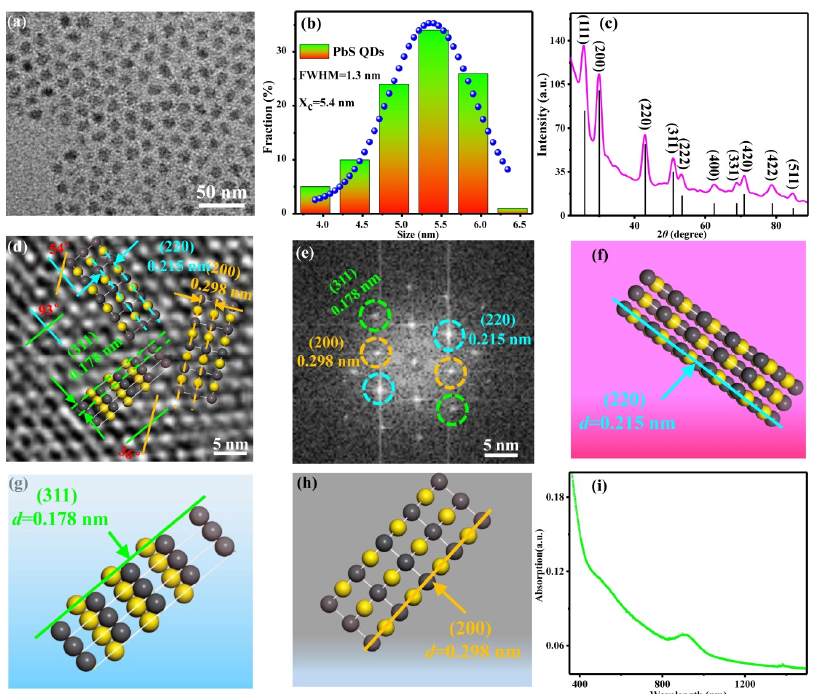
Figure 1. Structural characterization of PbS CQDs. ( a ) TEM image. ( b ) Histogram illustrating the particle size distribution. ( c ) XRD pattern. ( d ) HRTEM image. ( e ) FFT spectra. ( f – h ) Crystal structures of PbS CQDs with (220), (311) and (200) faces, respectively. ( i ) Optical absorption spectrum.